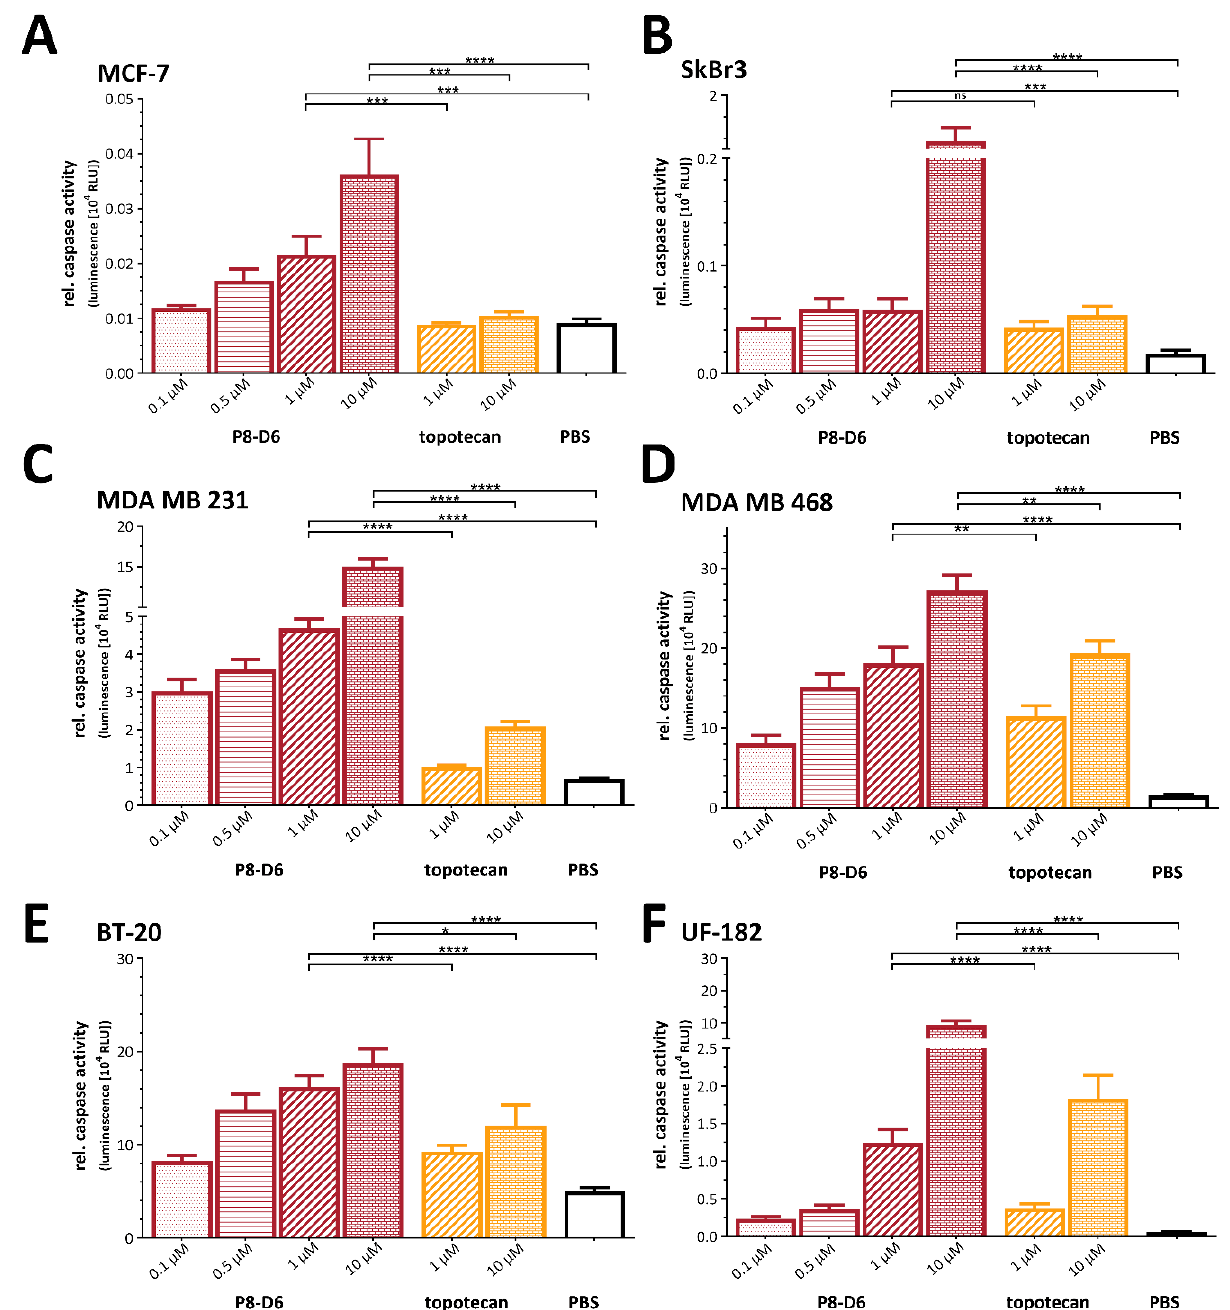
Figure 5. Apoptosis induction in BC spheroids. For 3D culture, MCF-7, SkBr3, MDA-MB231, MDA- MB468, BT-20 (cell line) and UF-182 (primary cells) cells were cultured in ULA plates for 96 h. Subsequently, spheroids were treated with P8-D6 (10 µ M, 1 µ M, 0.5 µ M, 0.1 µ M), topotecan (10 µ M, 1 µ M) and PBS for 48 h. After treatment, the viability and caspase activity were analyzed in MCF-7 ( A ), SkBr3 ( B ), MDA-MB231 ( C ), MDA-MB468 ( D ), BT-20 ( E ) and UF-182 ( F ) spheroids. Data are means + SD ( n = 3) one-way ANOVA, * ( p < 0.05), ** ( p < 0.01), *** ( p < 0.001), **** ( p < 0.0001), ns (non- significant).